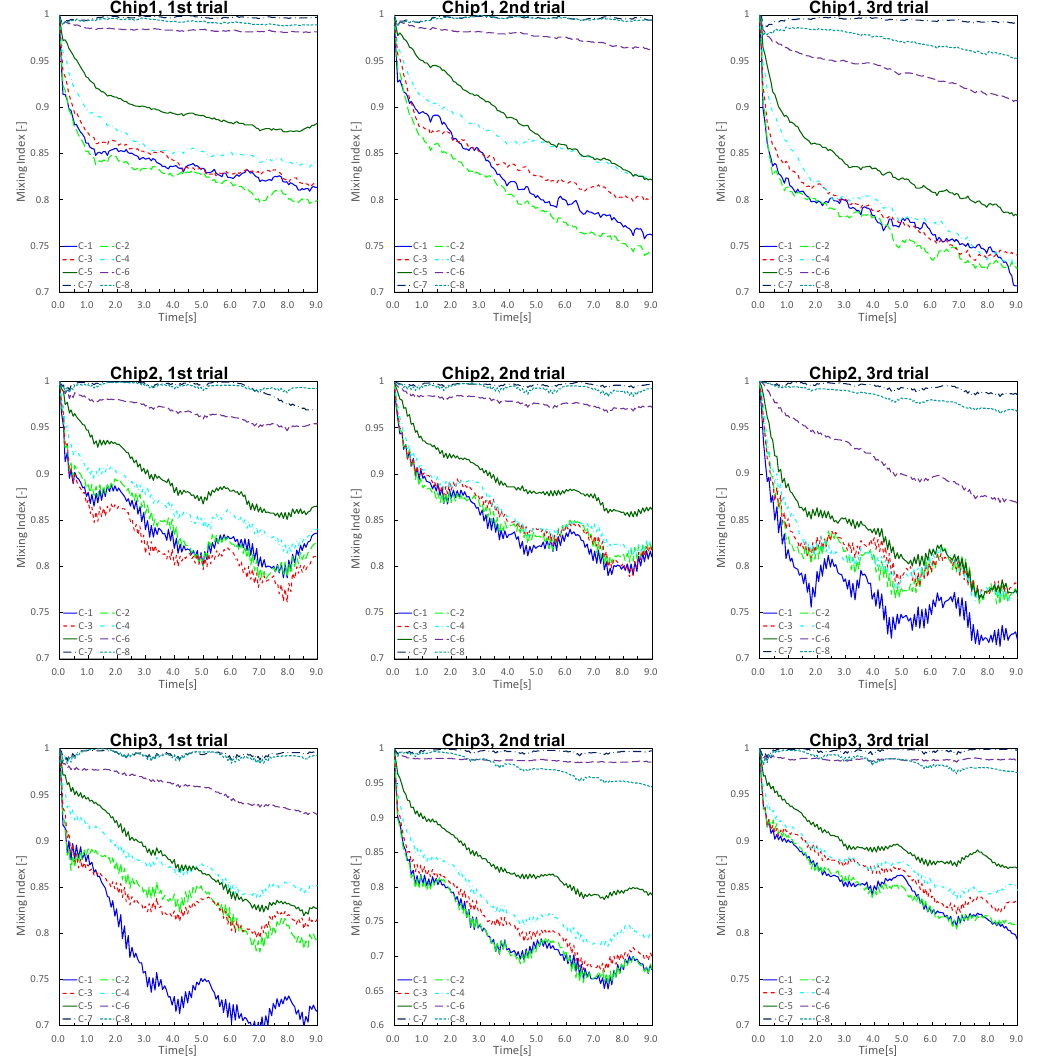
Figure 7. Time variation of mixing index until 9 s after application of air pressure. Graph was drawn using 3 points of a simple moving average. Mixing index indicates the degree of mixing; the lower the mixing index was, the more the beads were absorbed and mixed.